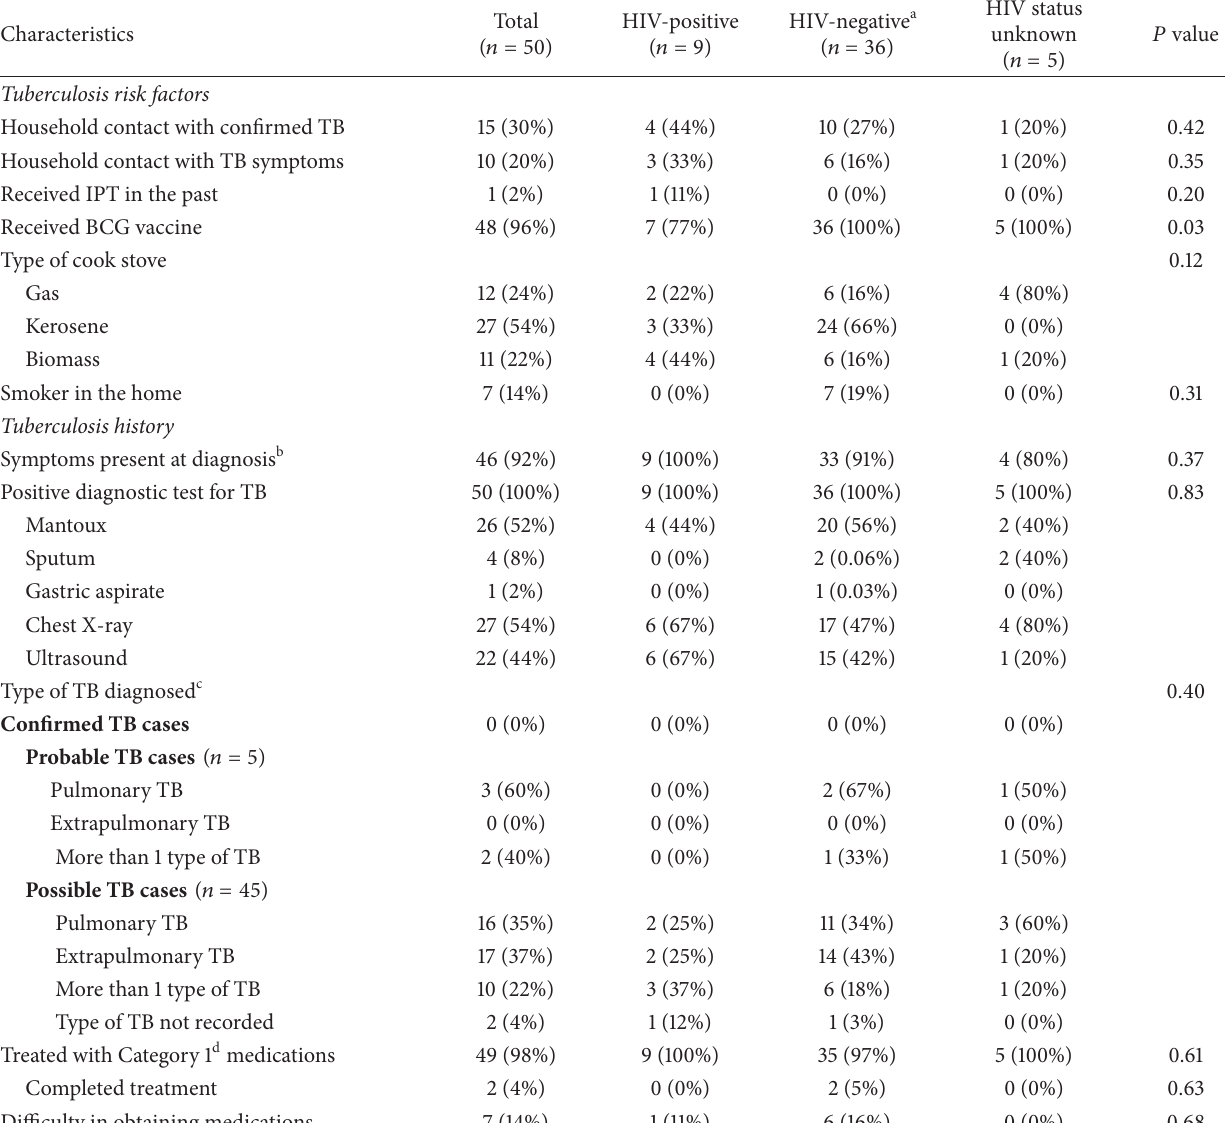
Table 2: Characteristics of pediatric index cases by HIV